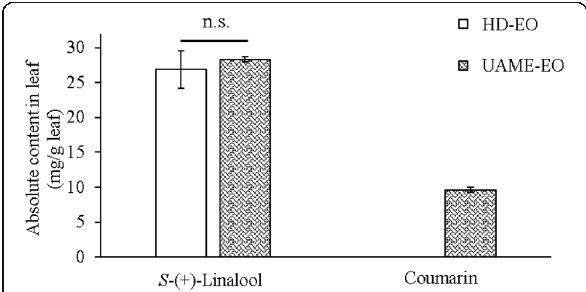
Fig. 2 Absolute content of S -(+)-linalool and coumarin from LEOs extracted by hydrodistillation (HD) and ultrasound-assisted microextraction (UAME). Data were presented as mean ± SD ( n = 3). n.s.: no significant difference when compared using Student ’ s t test ( p < 0.05)